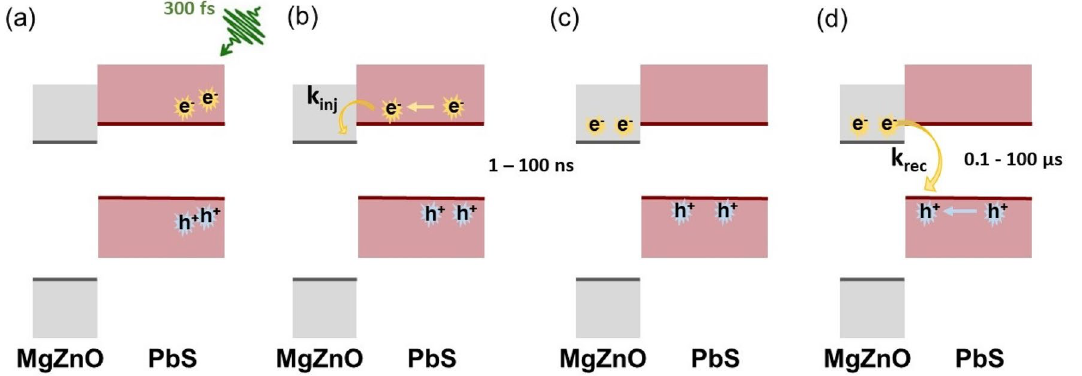
Figure 10. Scheme of electron dynamics occurring between two laser pulses at the MgZnO/PbS QD interface. ( a ) Interaction of the laser pulse and PbS QD layer leading to the creation of electron–hole pairs. ( b ) Diffusion of electrons and holes followed by electron transfer to the MgZnO. ( c ) Accumulation of electrons in the MgZnO layer. This is observed by the increase in ΔE B . ( d ) The system goes back to the equilibrium state, when electrons and holes move to the boundary, where they recombine with a rate constant of k rec . This process is observed by a decrease in ΔE B